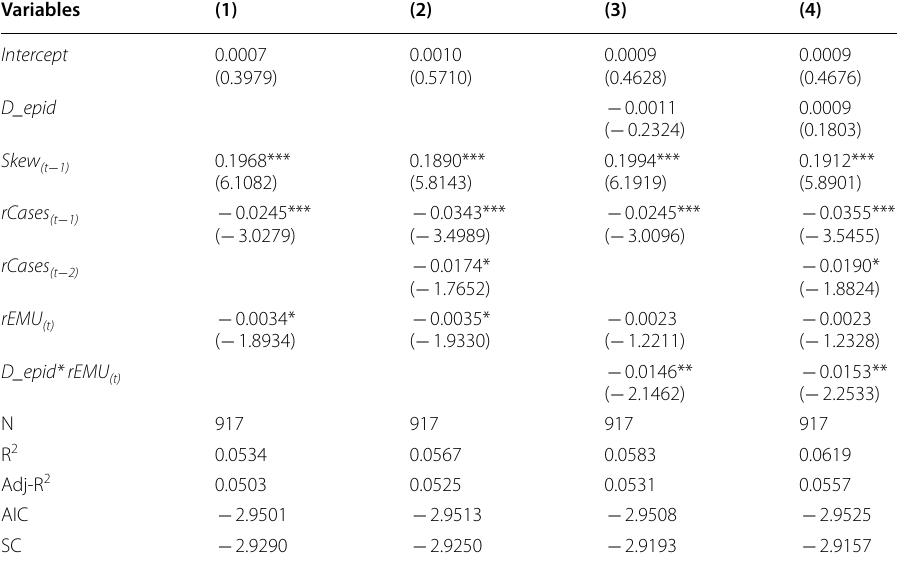
*** , **, * represent statistical significance at 1%, 5%, and 10% levels, respectively. The t‑statistics are presented in the brackets